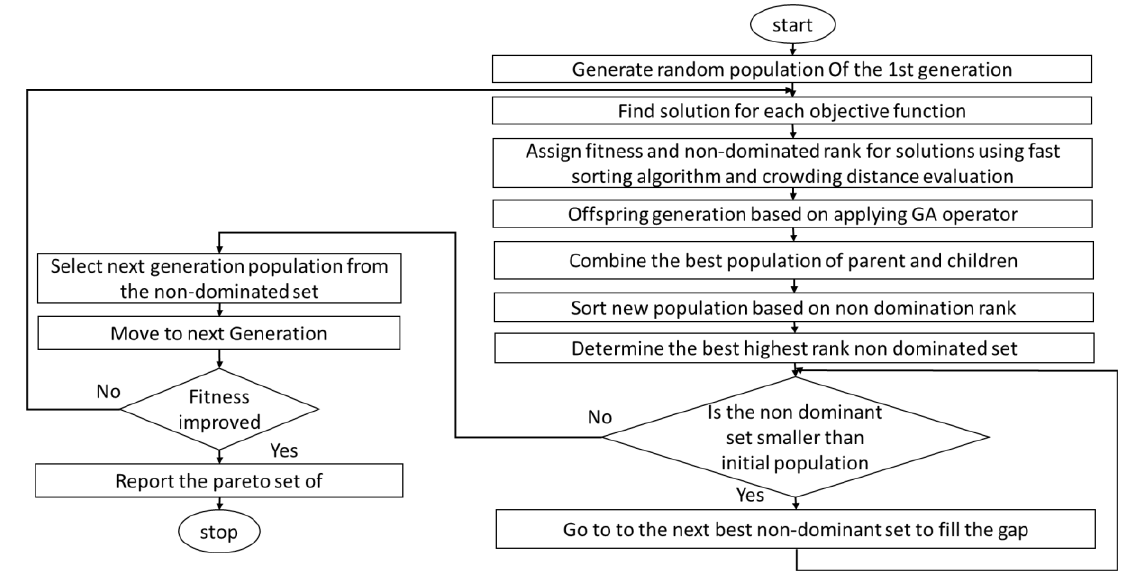
Figure 3. The nondominated rank-based sorting genetic algorithm (NSGA).